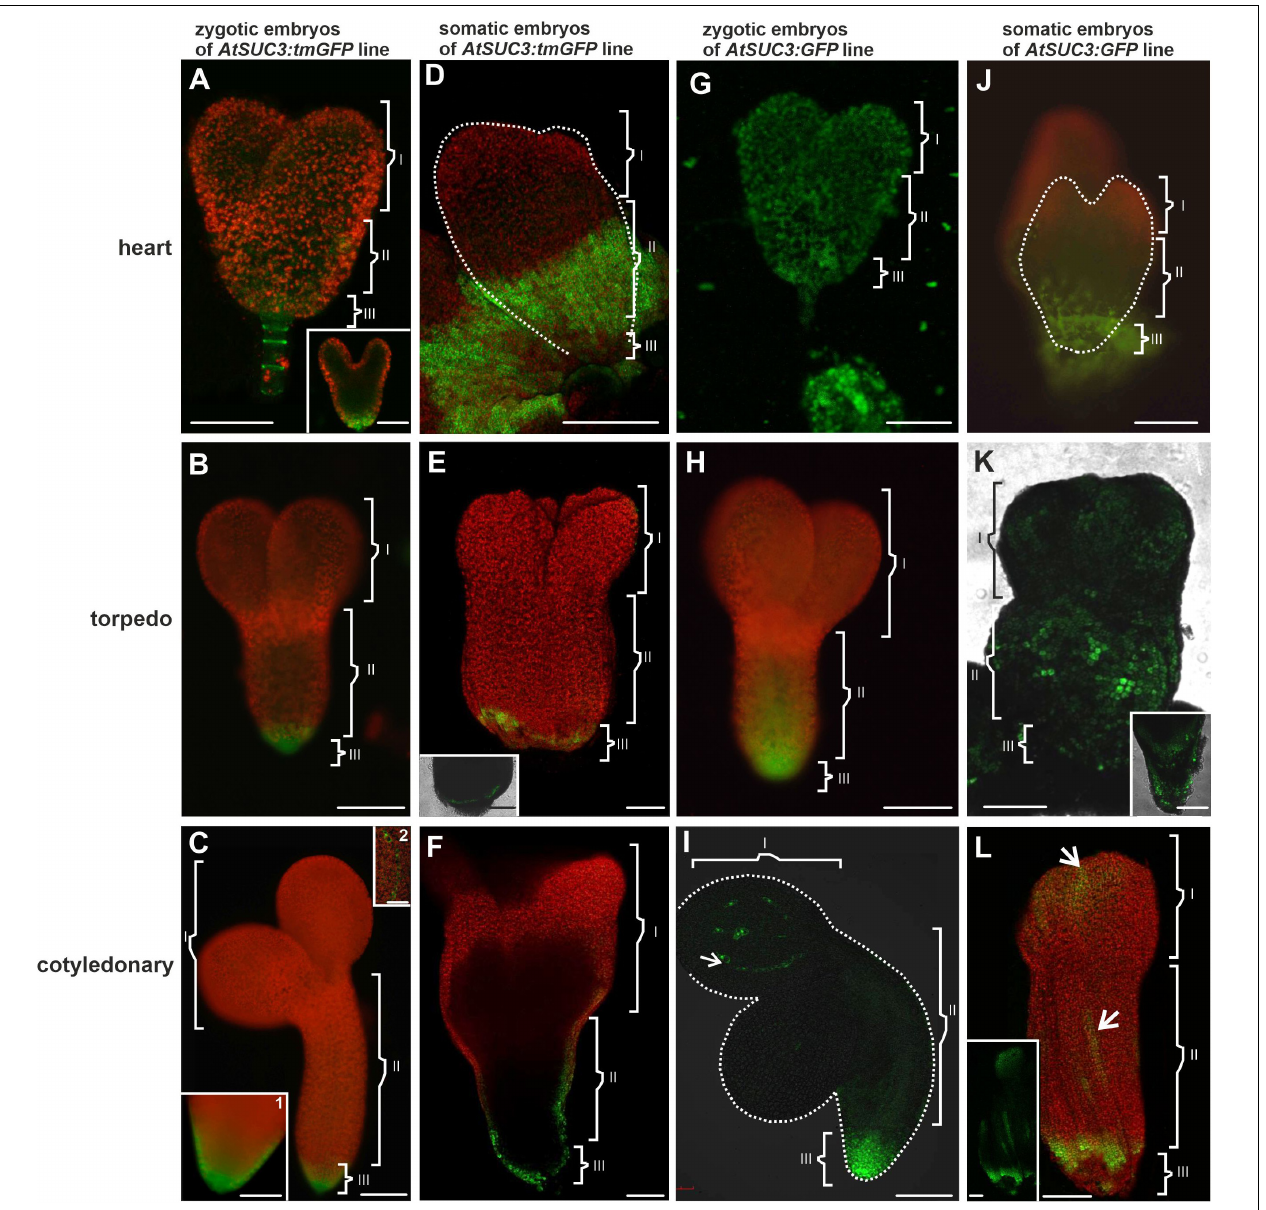
FIGURE 4 | The AtSUC3 promoter activity and GFP distribution in the ZEs and SEs. The AtSUC3 promoter was active in the ZE (A) in the heart, (B) torpedo, and (C) cotyledonary stages. In SE: (D) in the heart, (E) torpedo, and (F) cotyledonary stages, the promoter activity was in the central and basal parts of the embryo. The GFP distribution in (G) the heart, (H) torpedo, and (I) cotyledonary stages of the ZE. GFP in (J) the heart, (K) torpedo, and (L) cotyledonary stages of the SE embryos. (K inset) An optical section through the basal part of the hypocotyl. (L inset) – confocal image showed that the GFP fluorescence was only in the protodermal cells. Dotted lines indicate the embryo surface. ( I, II, and III – description is the same as for Figure 1 ). A–C,C insets,D,G,H,J – images from the epifluorescence microscope; E,E inset,F,I,K,L – images from the CLSM. Scale bars: A,A inset G – 50 µ m; B,C,C inset 1,D–F,H,I–K,K inset,L,L inset = 100 µ